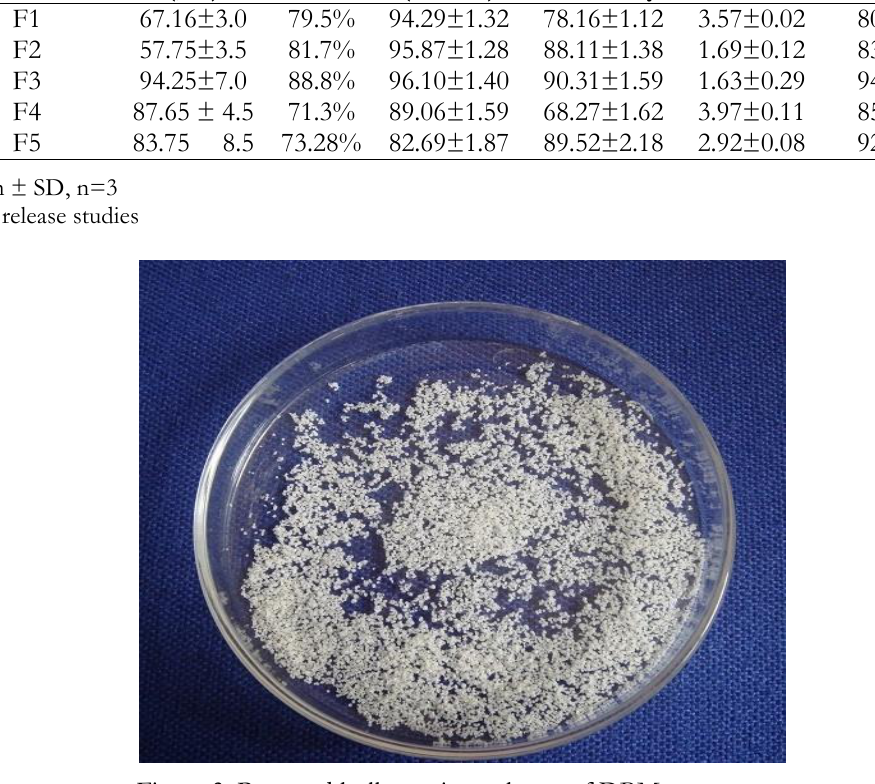
Table III. Evaluation parameters of DBM hollow microspheres Formulations